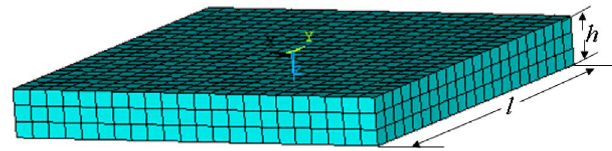
Figure 1. The fi nite element model of a square thin